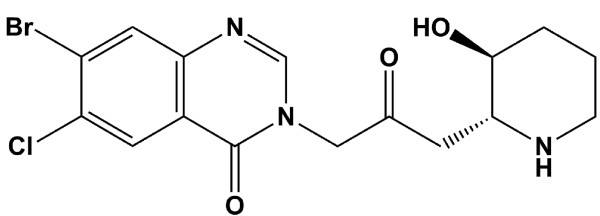
Halofuginone (HF).